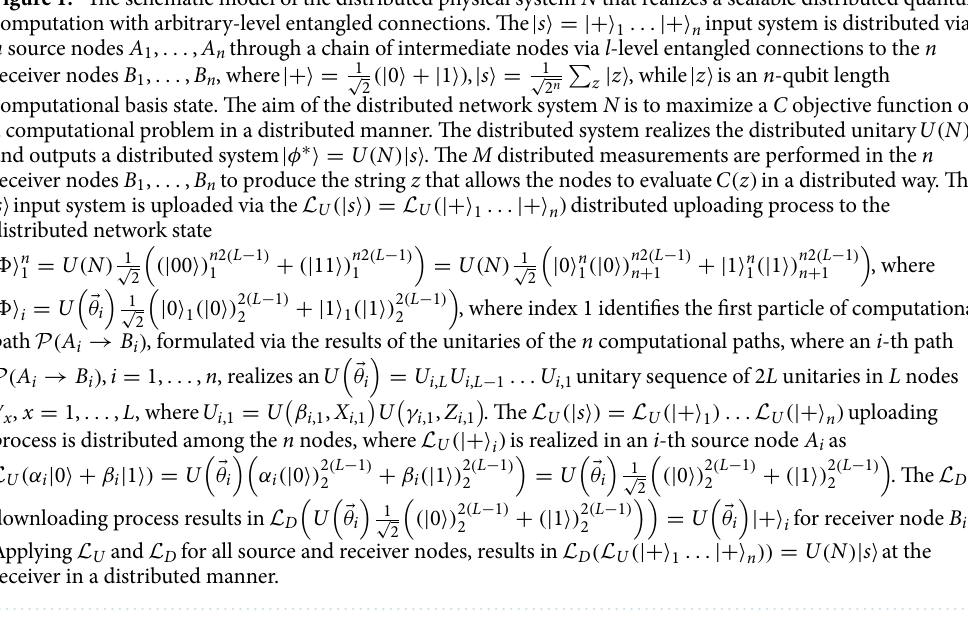
Figure 1. The schematic model of the distributed physical system N that realizes a scalable distributed quantum computation with arbitrary-level entangled connections. The n source nodes A 1 , . . . , A n through a chain of intermediate nodes via l -level entangled connections to the n receiver nodes B 1 , . . . , B n , where